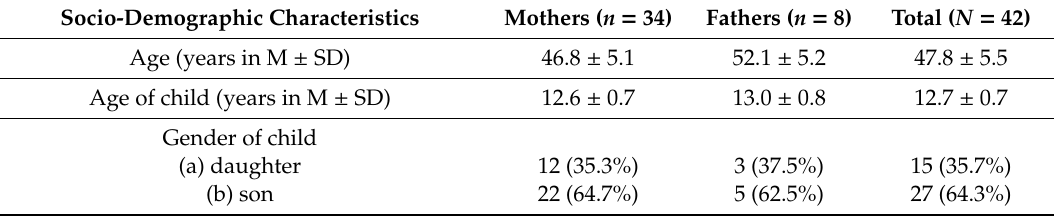
Table A3. Parents’ and their Child’s Socio-Demographic Characteristics based on the Sample of